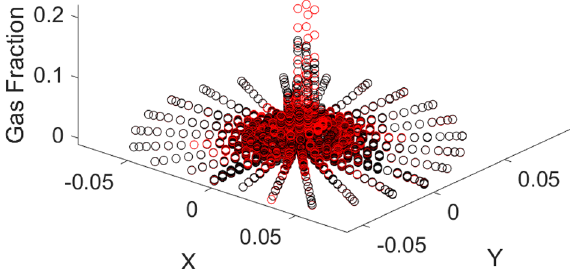
Figure 9. CFD pattern comparison with AI pattern. The red color shows CFD, and the black dot shows AI data.